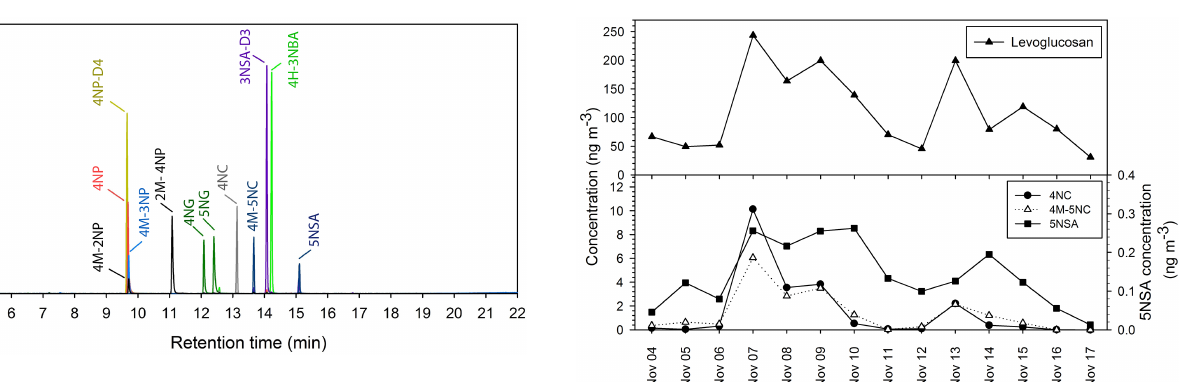
Figure 4. Selected ion chromatogram for a mixture of ni- tromonoaromatics standard (5ngmL − 1 ) , where 4M-2NP is 4- methyl-2-nitrophenol, 4NP is 4-nitrophenol, 4NP-D 4 is 4- nitrophenol-D 4 , 4M-3NP is 4-methyl-3-nitrophenol, 2M-4-NP is 2-methyl-4-nitrophenol, 4NG is 4-nitroguaiacol, 5-NG is 5- nitroguaiacol, 4NC is 4-nitrocatechol, 4M-5NC is 4-methyl-5- nitrocatechol, 3NSA-D 3 is 3-nitrosalicylic acid-D 3 , 4H-3NB is 4- hydroxy-3-nitrobenzyl alcohol, and 5NSA is 5-nitrosalicylic acid.